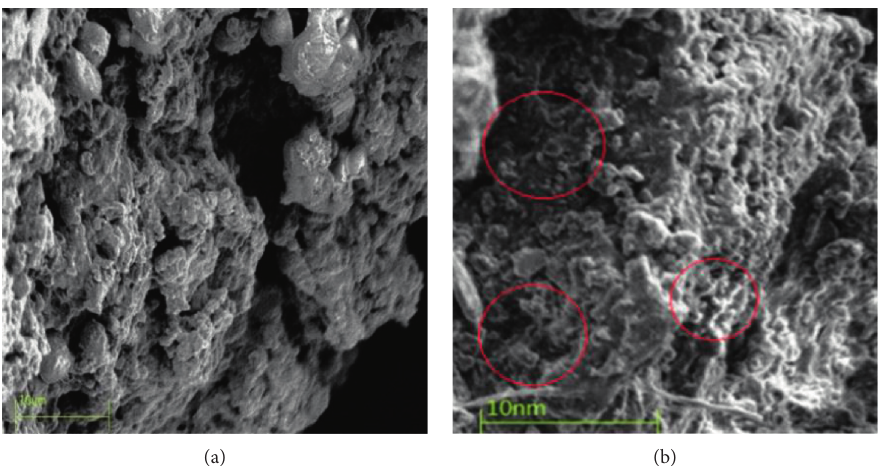
Figure 5: Electron microscopic scan of ordinary rubber powder and rubber powder with additives: (a) ordinary rubber powder (1500x); (b) rubber powder with additives